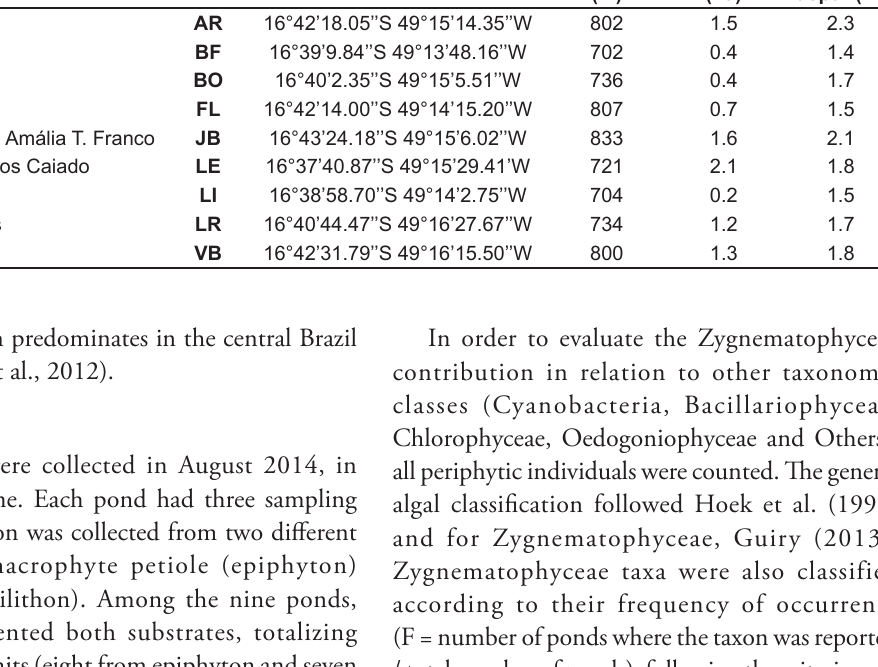
Table 1. Geographic coordinates and morphometric data of nine urban eutrophic ponds from Goiânia, GO. Ponds Codes Geographic coordinates